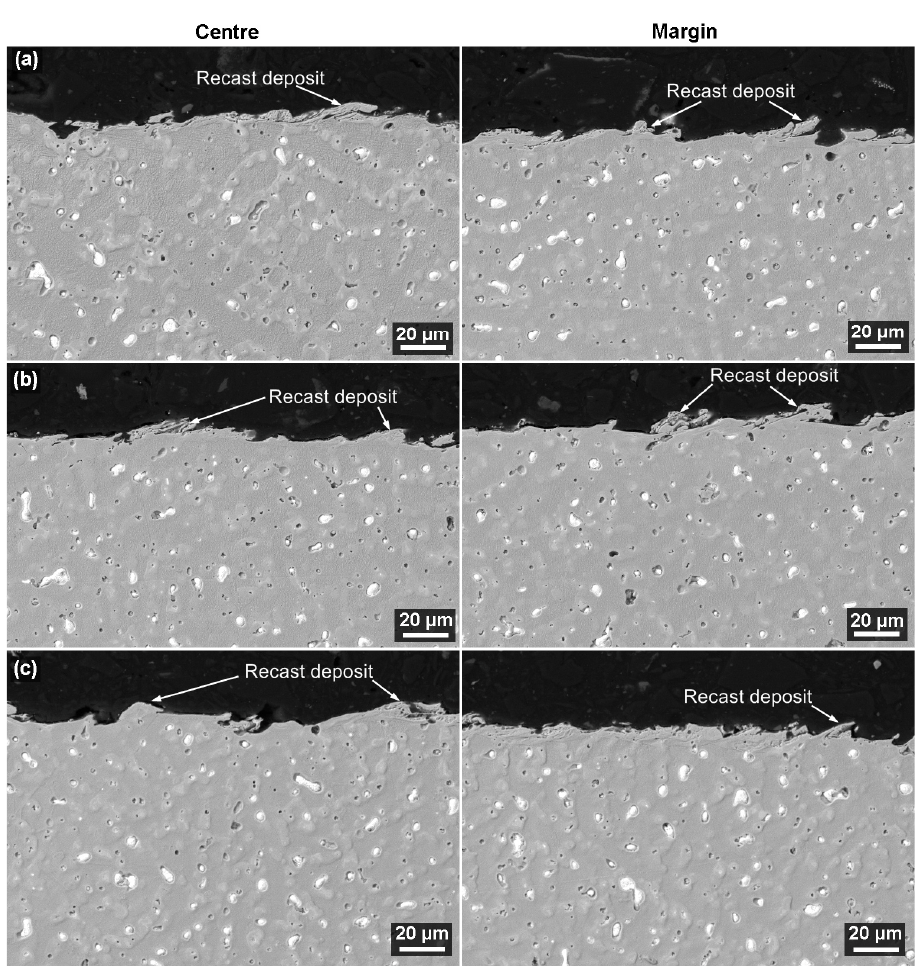
Figure 9. Cross ‐ section of the sample in the center and margin positions SEM/BSE, ( a ) sample with a thickness of 5 mm, ( b ) sample with a thickness of 80 mm, ( c ) sample with a thickness of 160 mm.